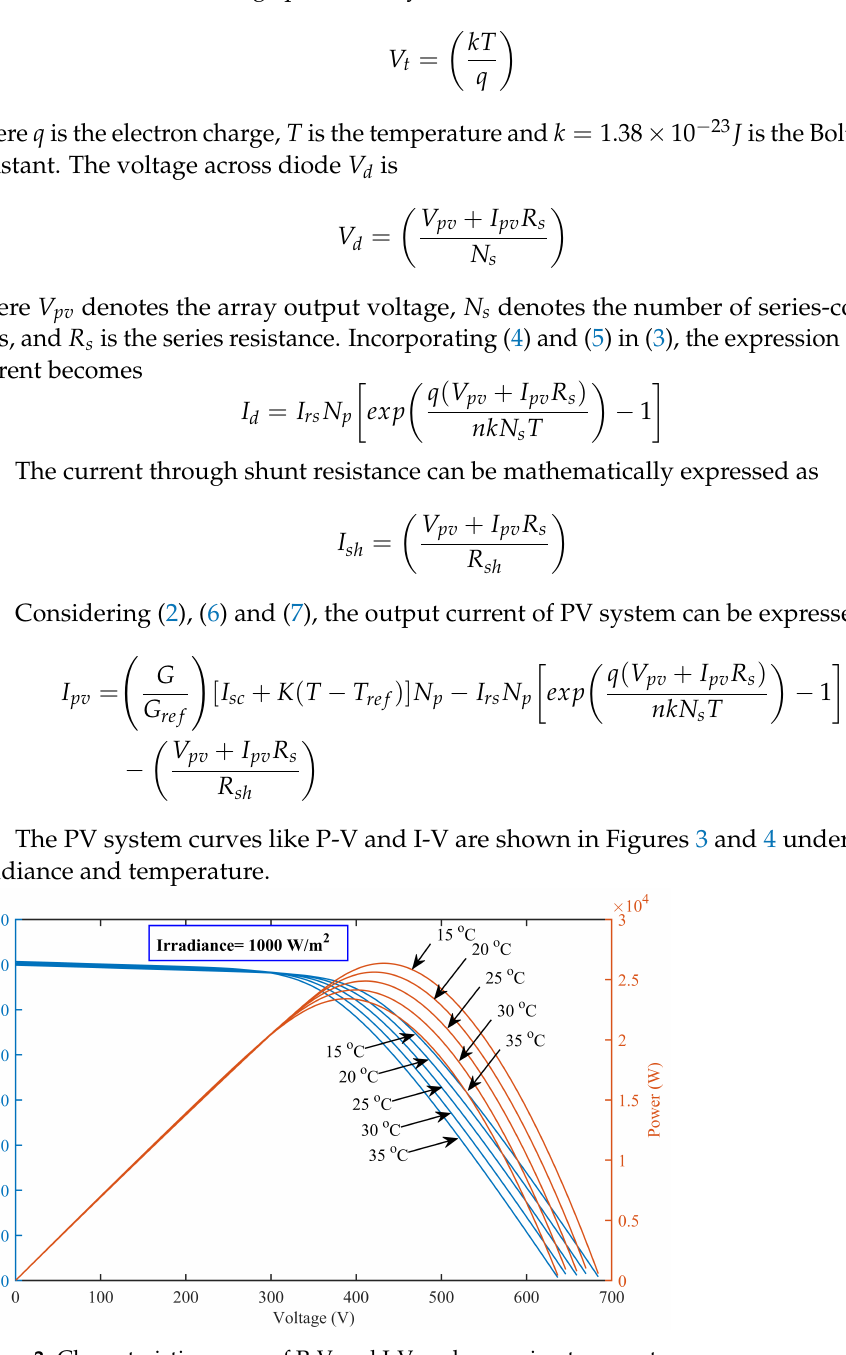
Figure 3. Characteristic curves of P-V and I-V under varying